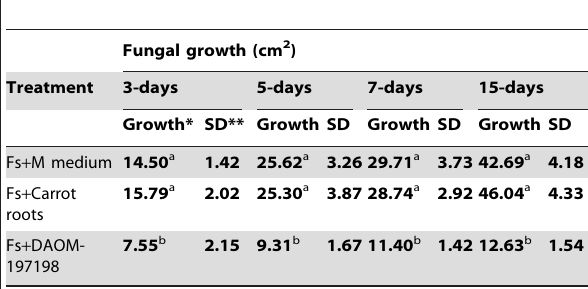
Table 2. Effect of G. irregulare on growth of F. sambucinum